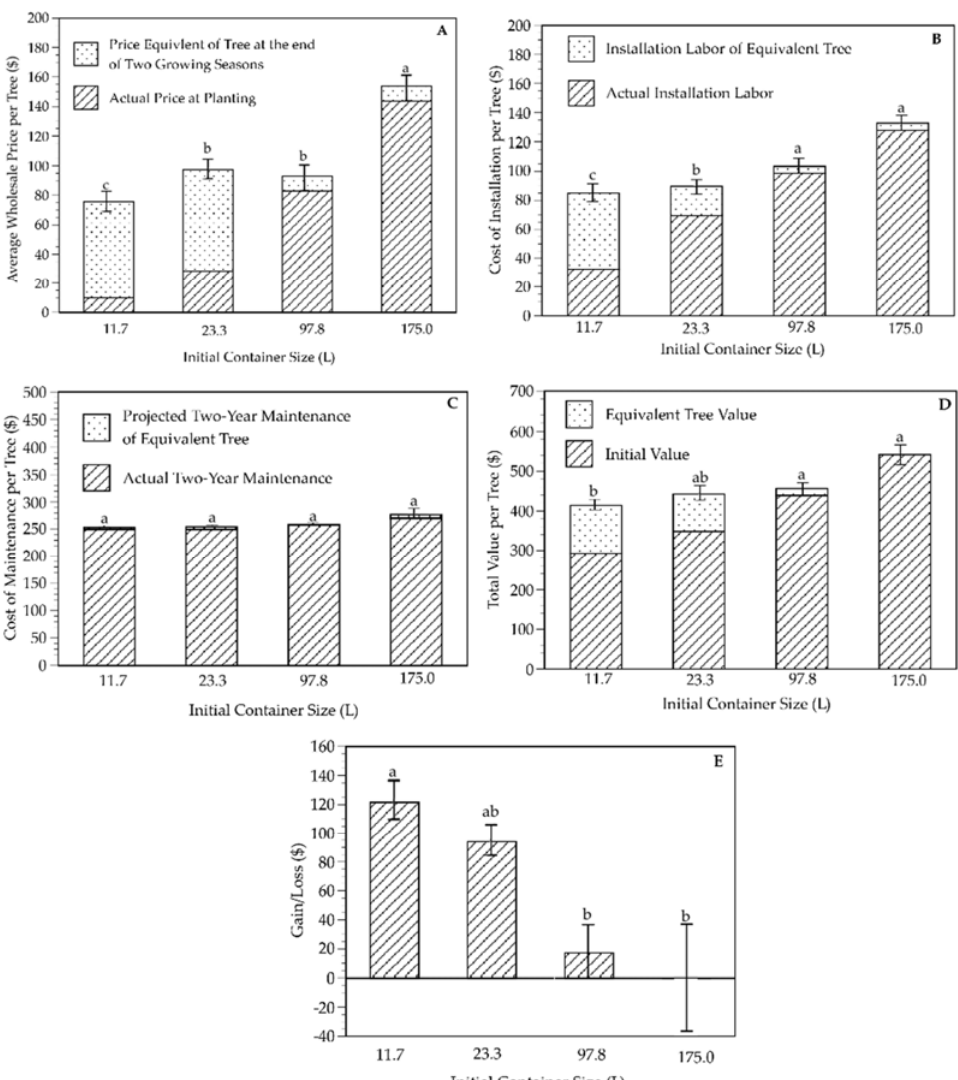
Figure 5. Mean ( ± standard error) wholesale cost ( A ), installation ( B ), maintenance cost ( C ), value ( D ), and gain or loss in dollars [US$] ( E ) of Acer rubrum trees from transplant (diagonal hatching) to the end of the second growing season (stippled hatching) for initial container sizes of 11.7, 23.3, 97.8 and 175.0 L trees. Means of final values after two growing seasons for initial container sizes with the same letter are not significantly different at p ≤ 0.05 using Student’s t ‐ test.